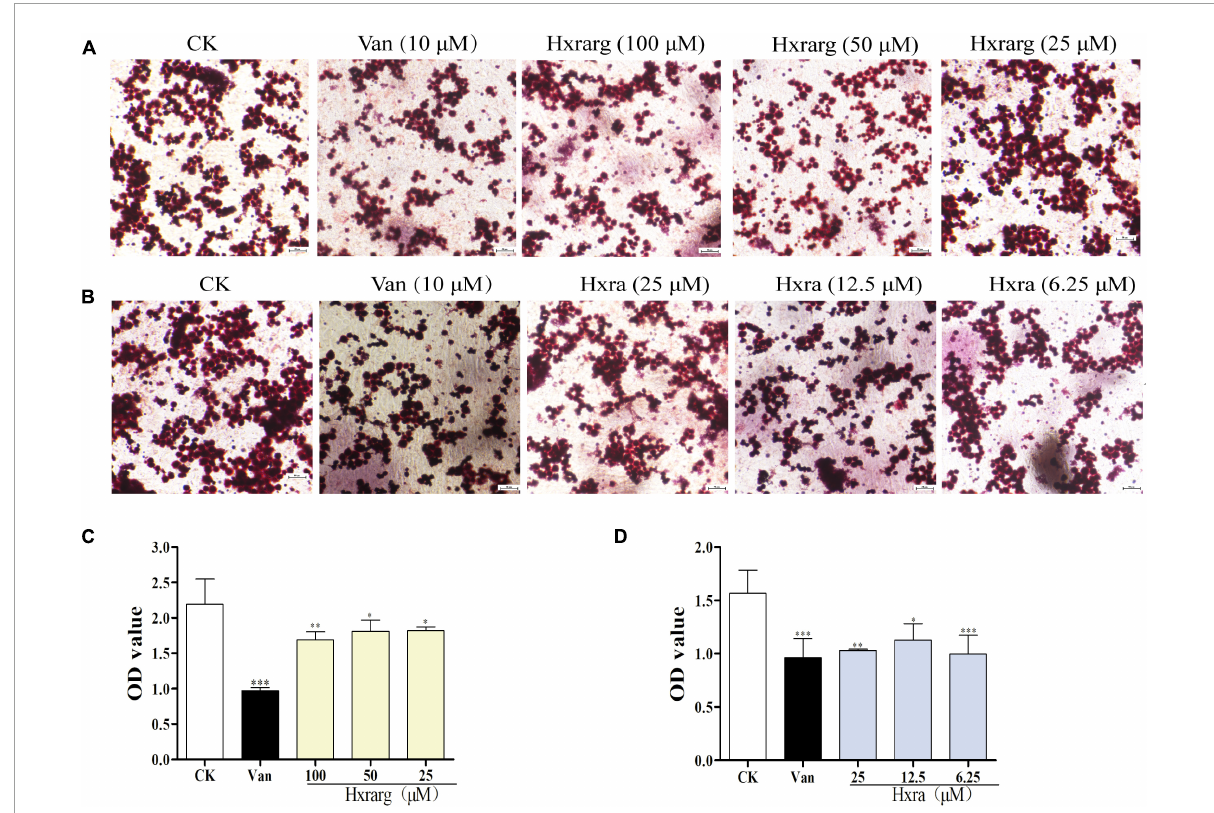
FIGURE4 Inhibition of lipid droplet formation by Hxrarg (A) and Hxra (B) . Effects of Hxrarg (C) and Hxra (D) on lipid accumulation during 3T3-L1 differentiation. Compared with control group, ∗ P < 0.05, ∗∗ P < 0.01, ∗∗∗ P <